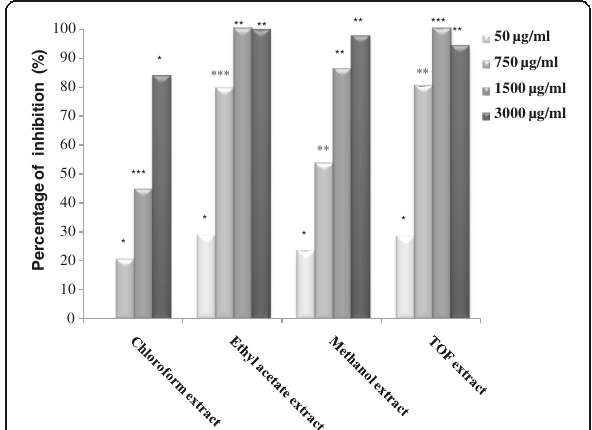
Figure 1 Inhibition of xanthine oxidase activity by D. gnidium leaf extracts. Results were expressed as percentage of inhibition of uric acid production compared to the control. Values represent the mean±SD of three separate experiments. The statistical significance of results was evaluated by the Student ’ s t-test. *P<0.05, **P<0.01, ***P<0.001 means significant difference between control and treated sample.